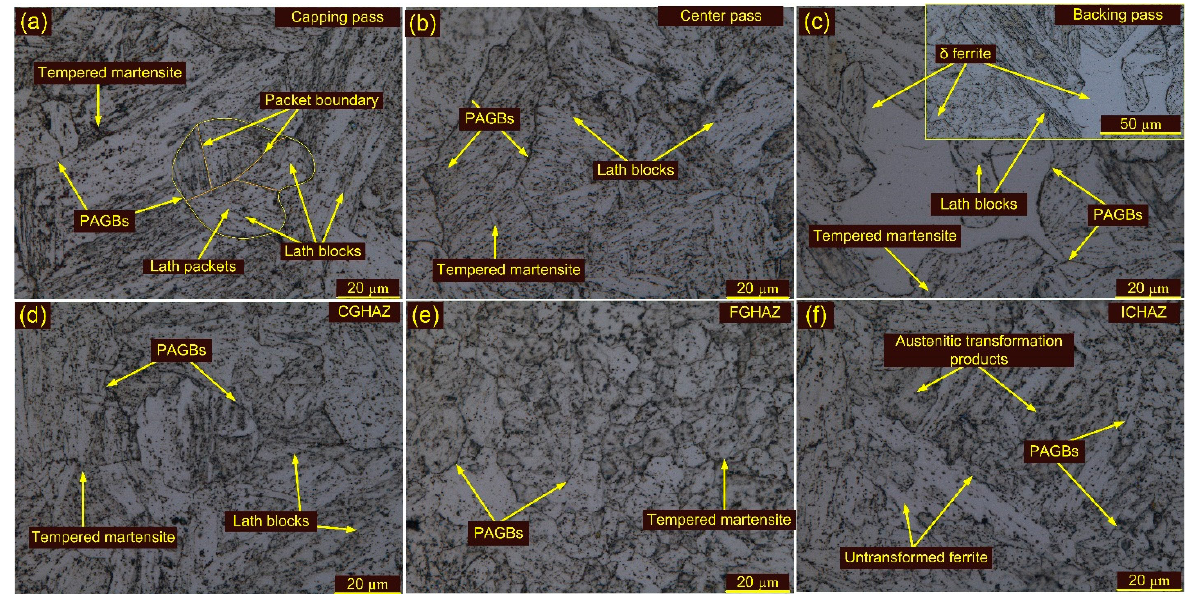
Figure 15. Weldments after HT2 treatment: WFZ ( a ) capping pass, ( b ) center pass, ( c ) backing pass; ( d ) CGHAZ, ( e ) FGHAZ, ( f ) ICHAZ.